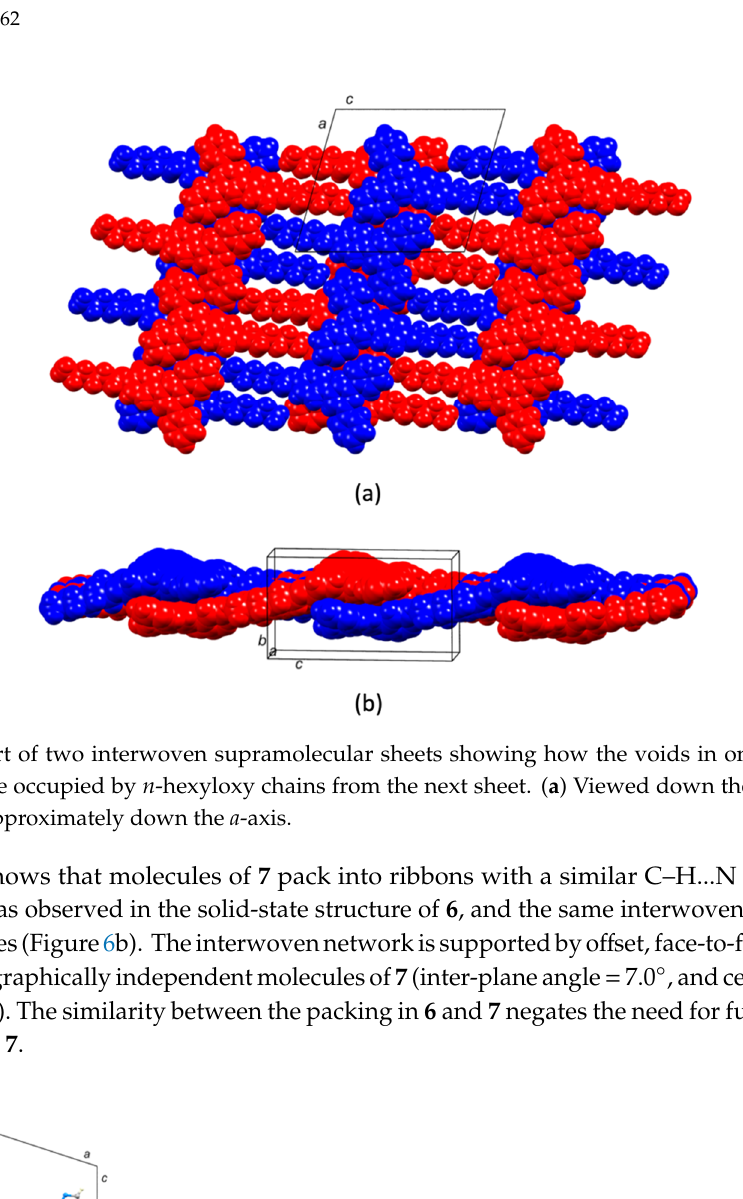
Figure 4. Molecules of 6 pack into 2D-sheets involving CH...N weak hydrogen bonds and van der Waals interactions between n -hexyloxy chains. The unit cell is viewed down the b -axis. ( a ) C–H...N hydrogen bonds and ( b ) a space-filling representation of part of one supramolecular sheet showing one void between pairs of n -hexyloxy chains.